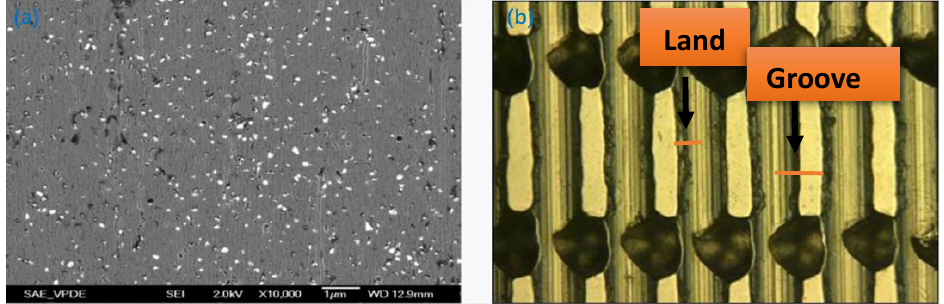
Figure 2. Abrasive distribution and Pit ratio of the tin plate: ( a ) abrasive distribution; ( b ) pit ratio check.